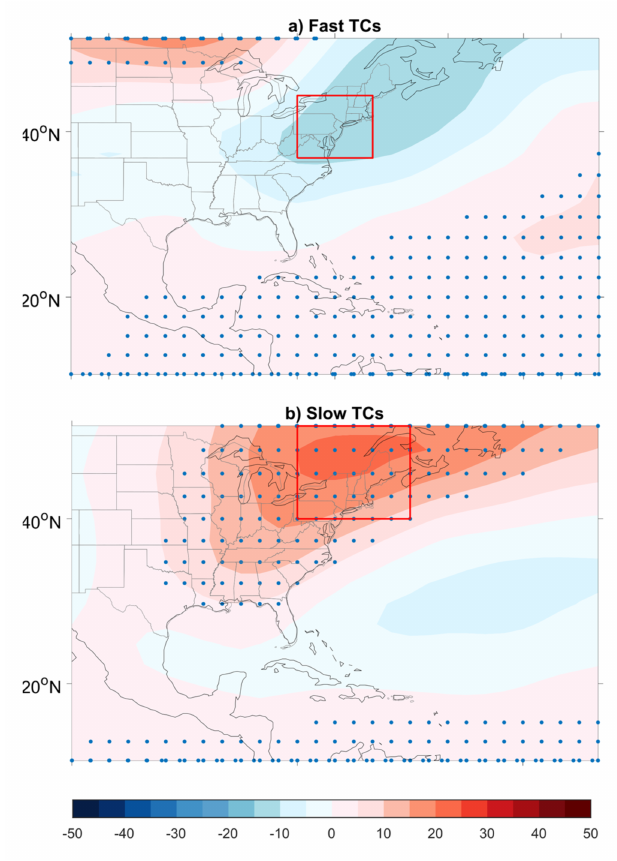
Figure 6. Composites of daily 500-hPa geopotential height anomaly for fast- and slow-moving tropical cyclones. Stippled regions represent those significant at the 0.05 level based on the Student’s t -test.